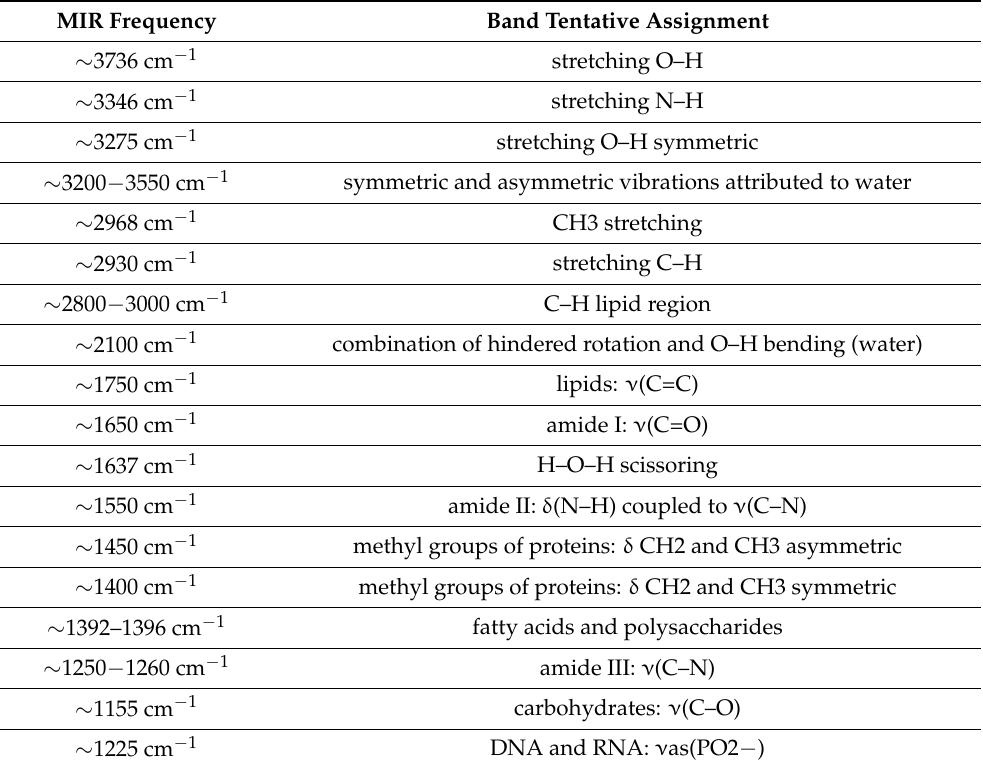
Table 2. Principal Mid-Infrared (MIR) Bands of the Dataset and Chemical Assignments